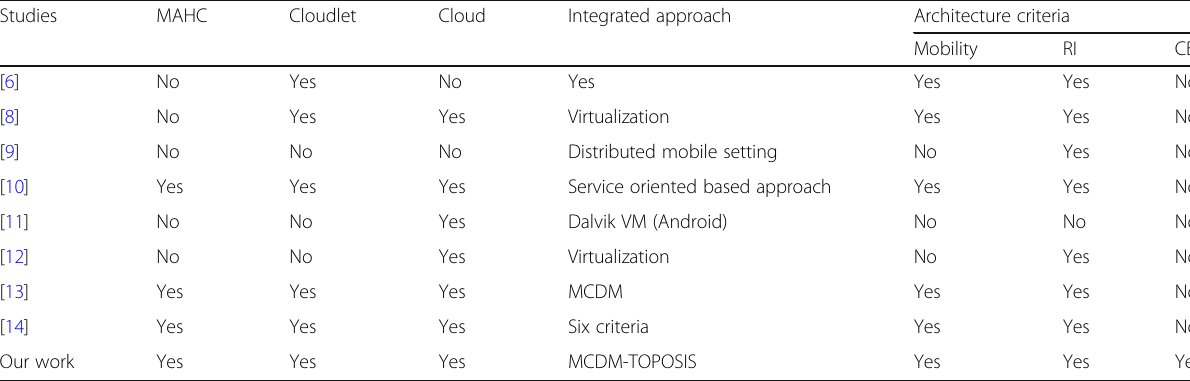
Table 1 Architecture comparison Studies